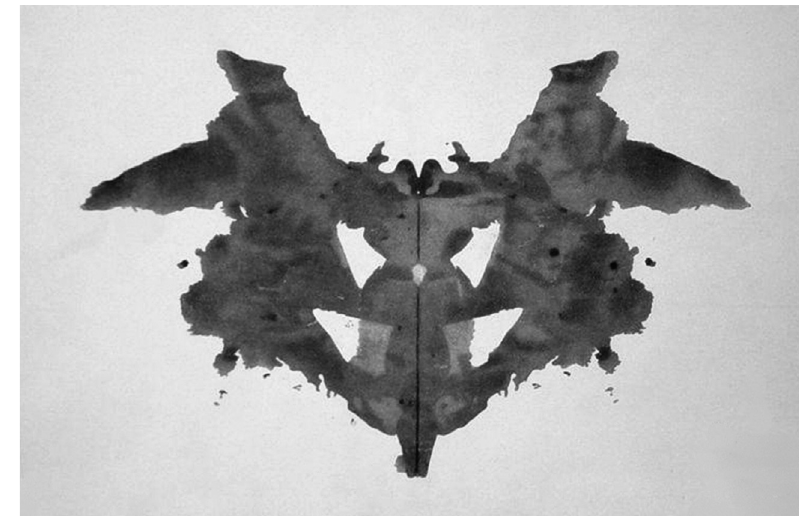
Figure 2. The first of the blots of the Rorschach inkblot test –